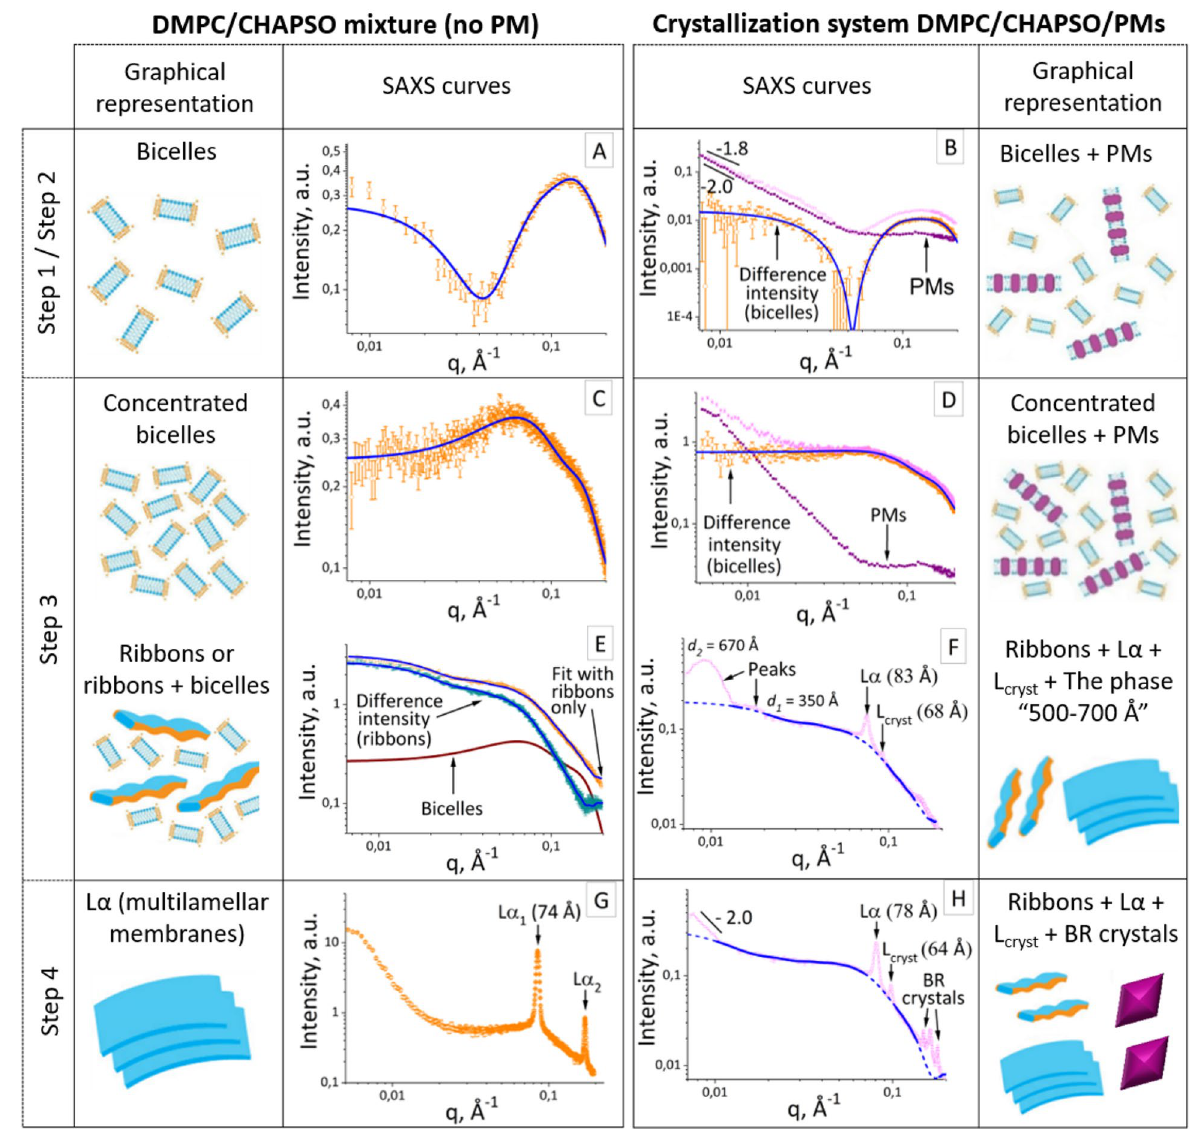
Figure 2. Evolution of the crystallization matrix during the crystallization process. The SAXS curves for the pure DMPC/CHAPSO mixture without PM (left) and the crystallization system DMPC/CHAPSO/PM (right). Experimental data for crystallization system with and without PM are shown as light purple and orange hollow circles, correspondingly. SAXS curves for PM are shown as dark purple squares. The approximations by form- factors of the bicelles and the ribbons are shown as blue lines. The graphical representations of the structural organizations of the crystallization matrix are shown adjacent to the corresponding SAXS